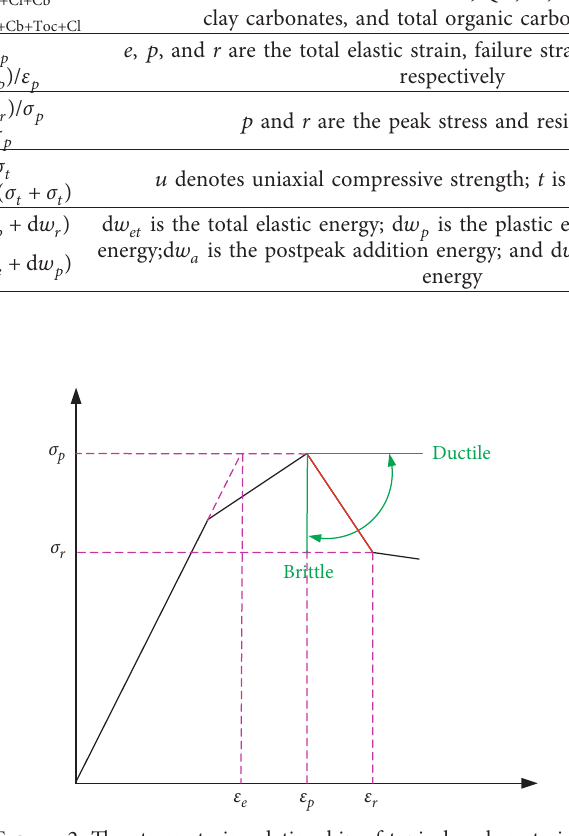
Figure 2: The stress-strain relationship of typical rock